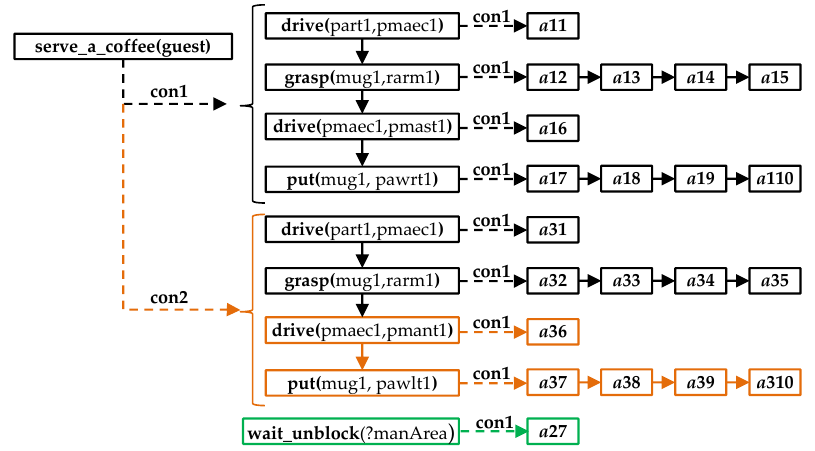
Figure 5. Structure of an activity schema with abstract methods ma . Dotted arrows indicate preconditions, and solid arrows indicate the order of execution. The middle rectangles represent the